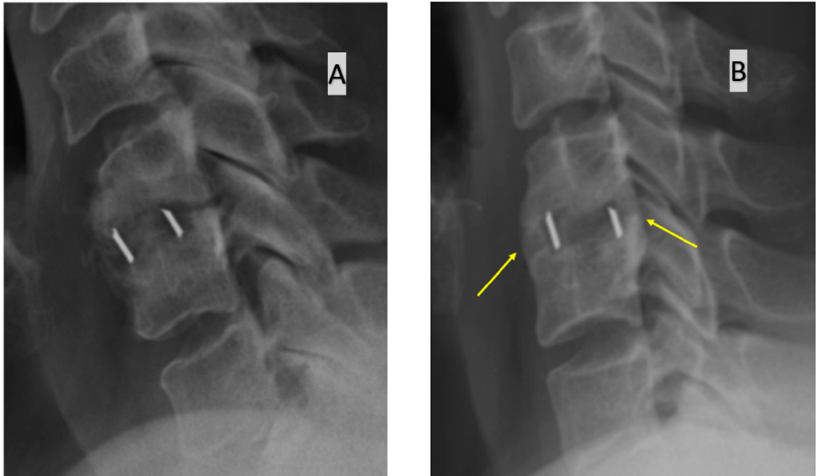
Figure 3. Assessment of bone fusion based on the identification of bone bridging on the anterior and/or posterior edge of the operated disc space. ( A ) radiograph at 12 months after surgery without bone bridging ( B ) radiograph at 12 months after surgery with bone bridging present (arrows).